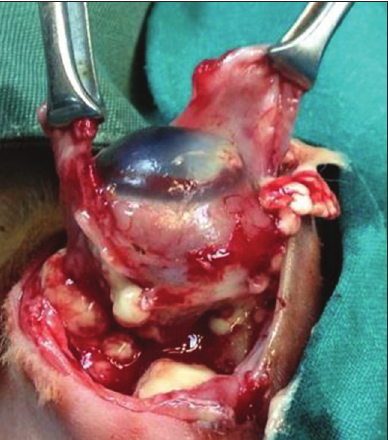
Figure-4: Surgical treatment of rabbit retrobulbar abscesses by enucleation and abscess drainage procedure.